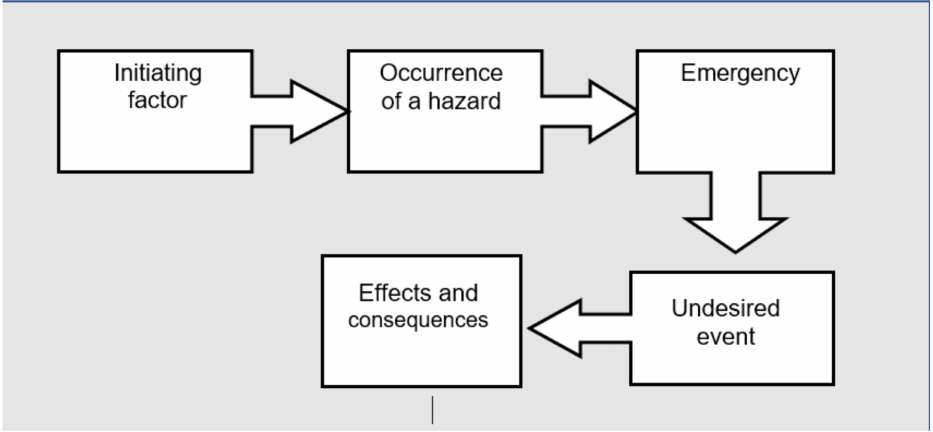
Figure 3. Flow chart of an adverse event.